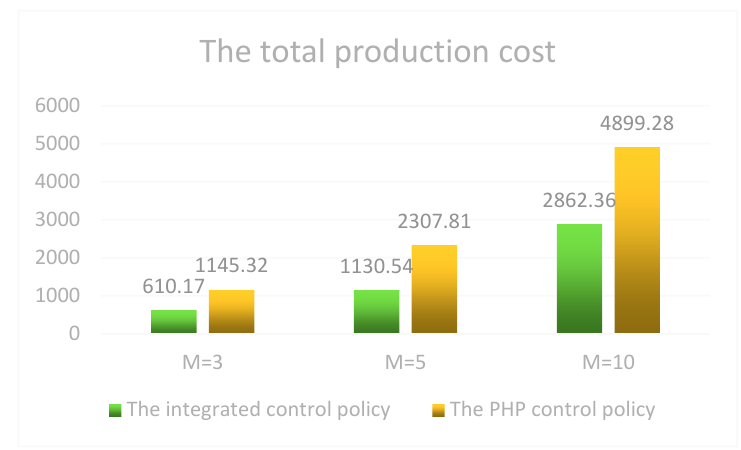
Figure 4. The total production cost under two control polities in Experiment 1.